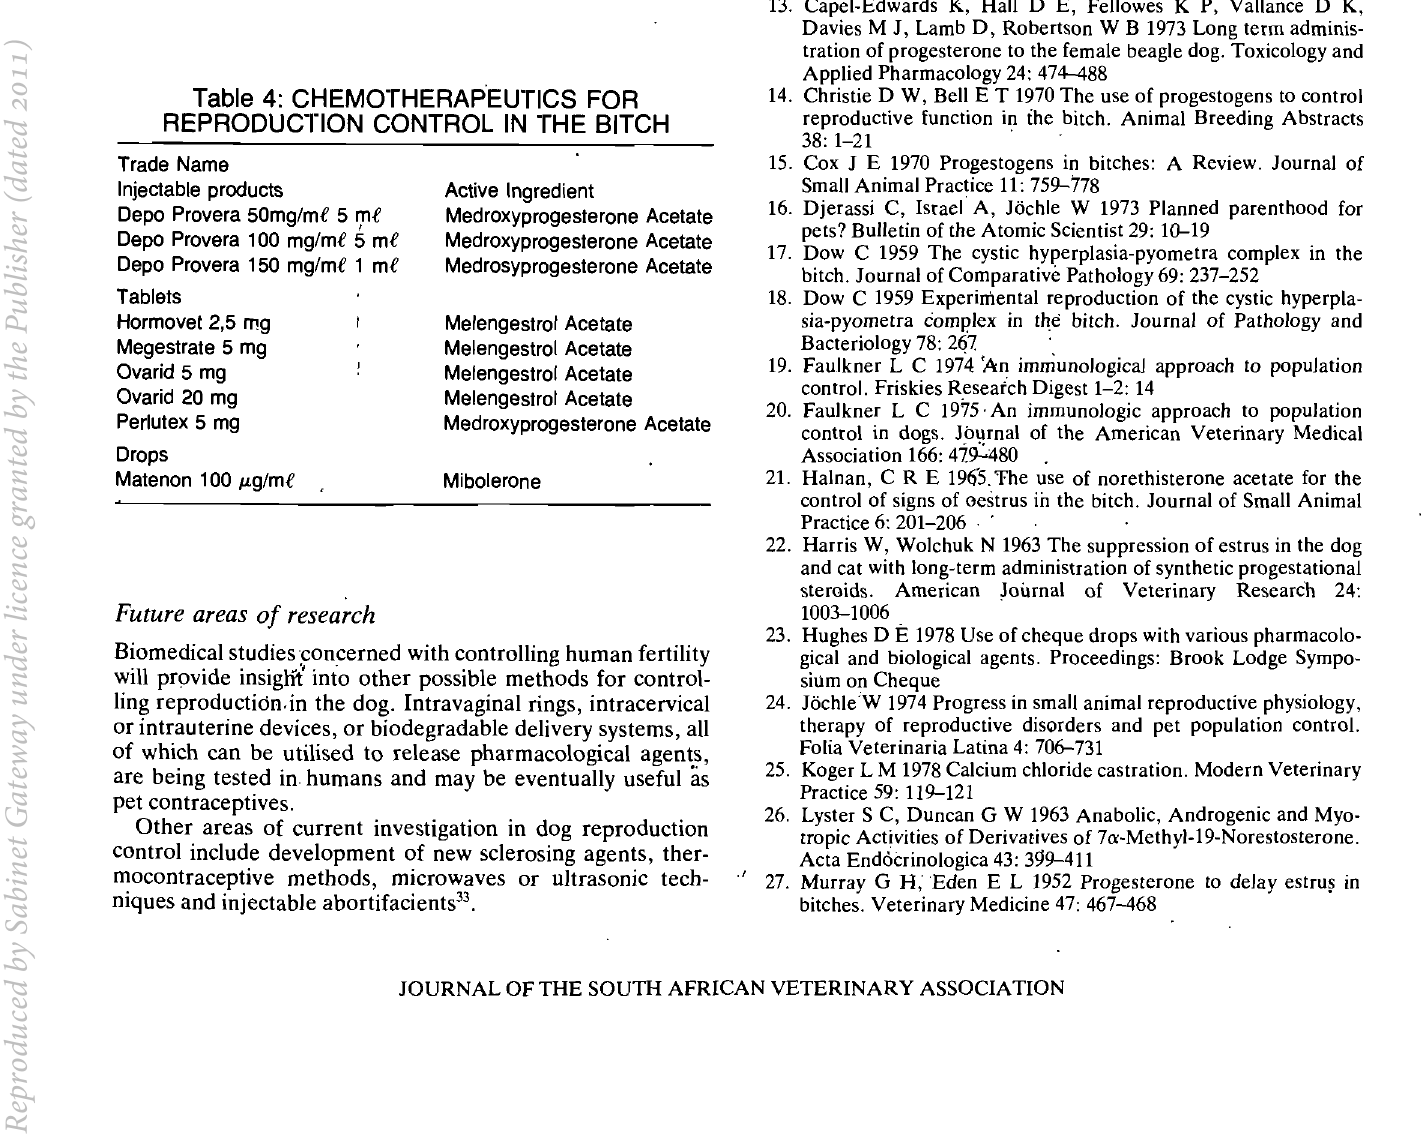
Table 4: CHEMOTHERAPEUTICS FOR REPRODUCTION CONTROL IN THE